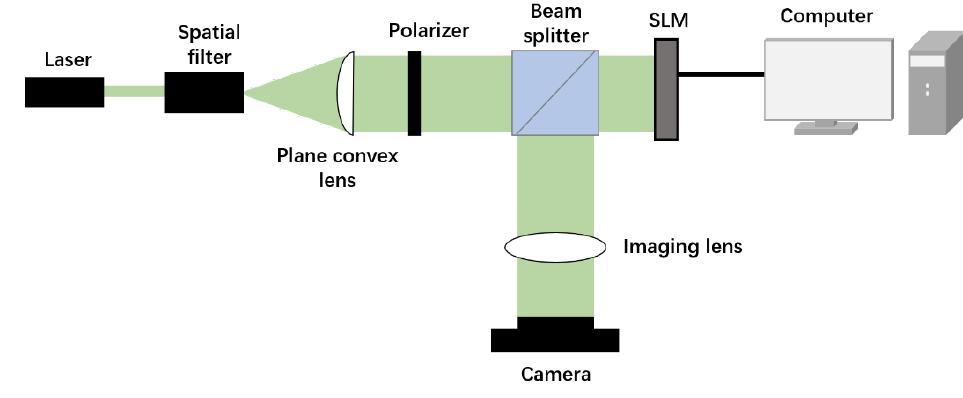
Figure 10. Optical reconstruction